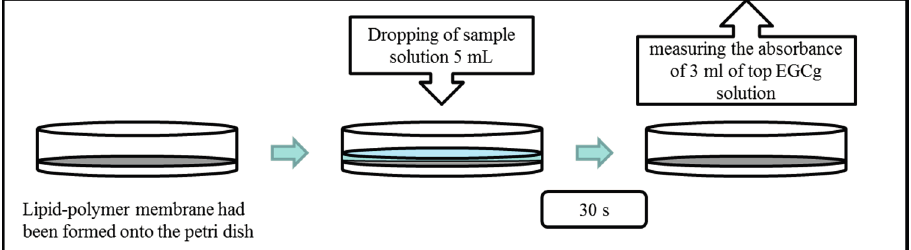
Figure 4. Measurement procedure of the amount of adsorbed EGCg.